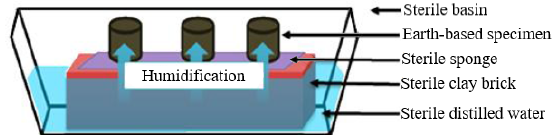
Figure 2. Diagram of the capillarity humidification